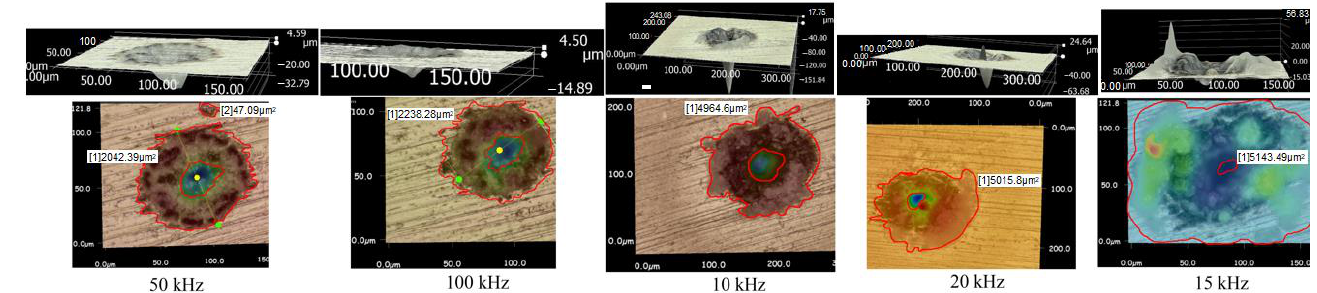
Figure 6. Spatter areas measured by 3D microscope, from the lowest SA (left) to the highest (right).